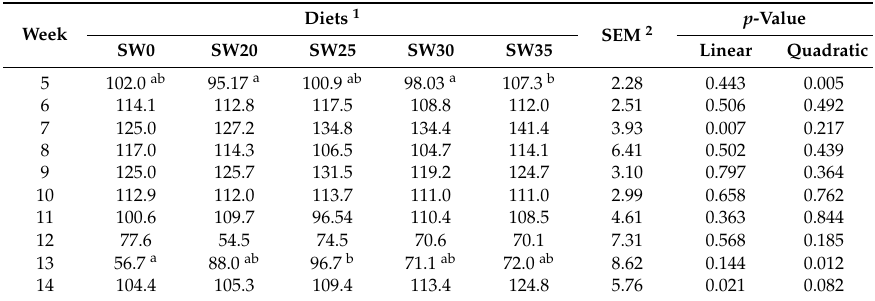
Table 5. Average weekly body weight gain (g / bird) of Boschveld indigenous hens fed diets containing seaweed